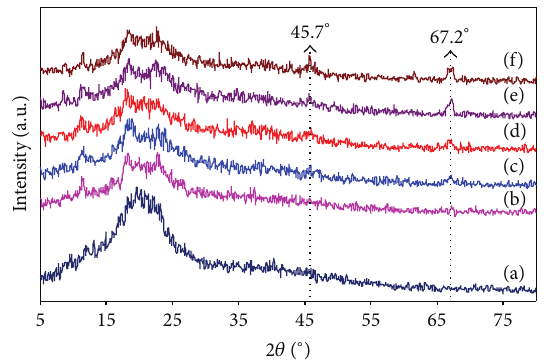
Figure 3: X-ray diffractogram of (a) CS: LiTf (90 :10), (b) CSNC1, (c) CSNC2, (d) CSNC3, (e) CSNC4, and (f)